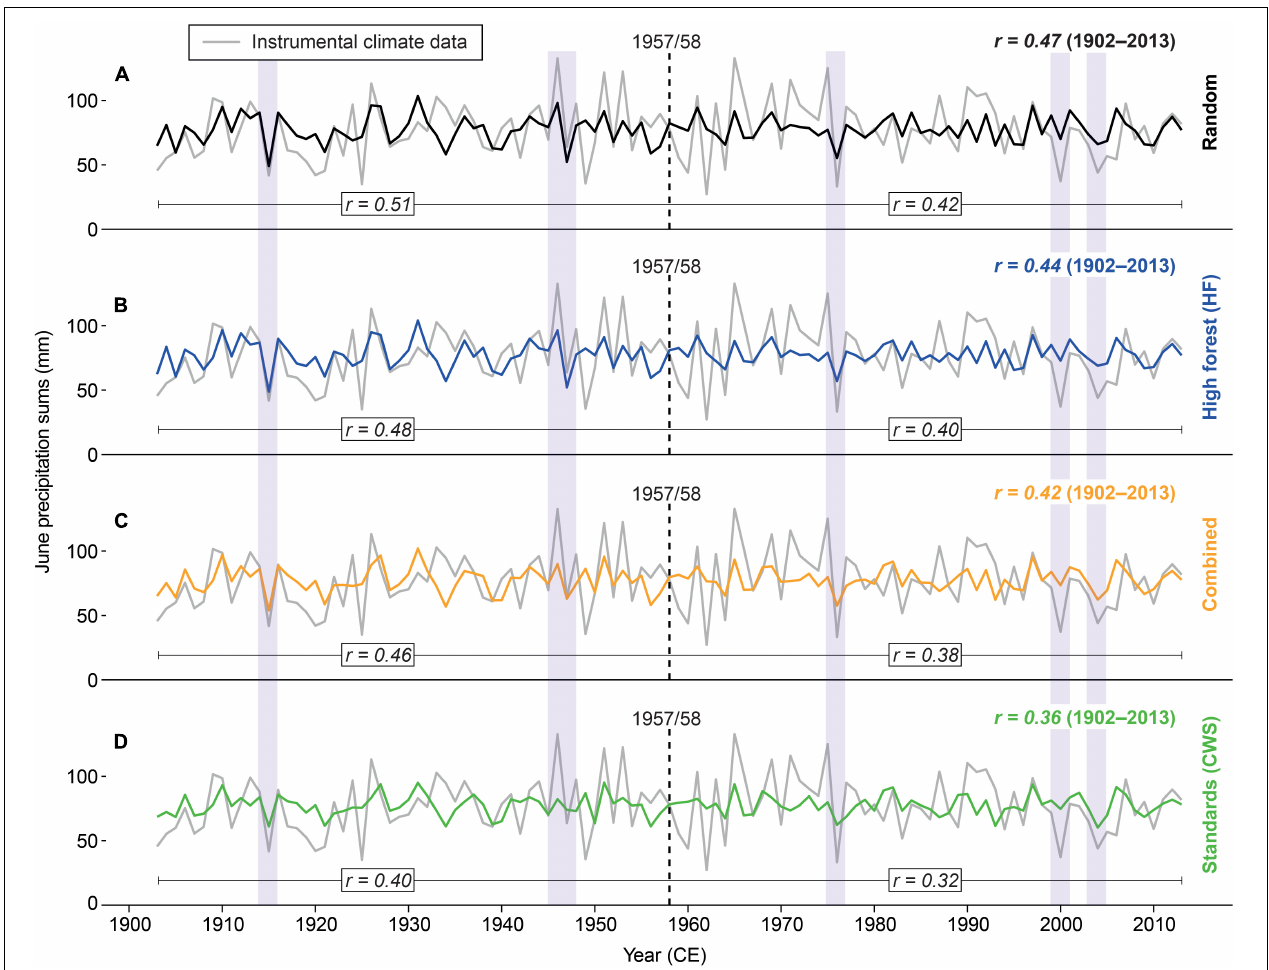
FIGURE 2 | Different regional June precipitation reconstructions for the period 1902–2013 (split calibration/verification periods 1902–1957 and 1958–2013, respectively) and comparison with instrumental climate data (gray). (A) Random chronology (black), (B) high forest (HF) chronology (blue), (C) combined chronology (orange), and (D) standards (CWS) chronology (green). Highlighted gray areas denote positive and negative hydroclimatic extremes that were used for visually assessing the accuracy of the reconstructions in years with extremely low and high June precipitation.